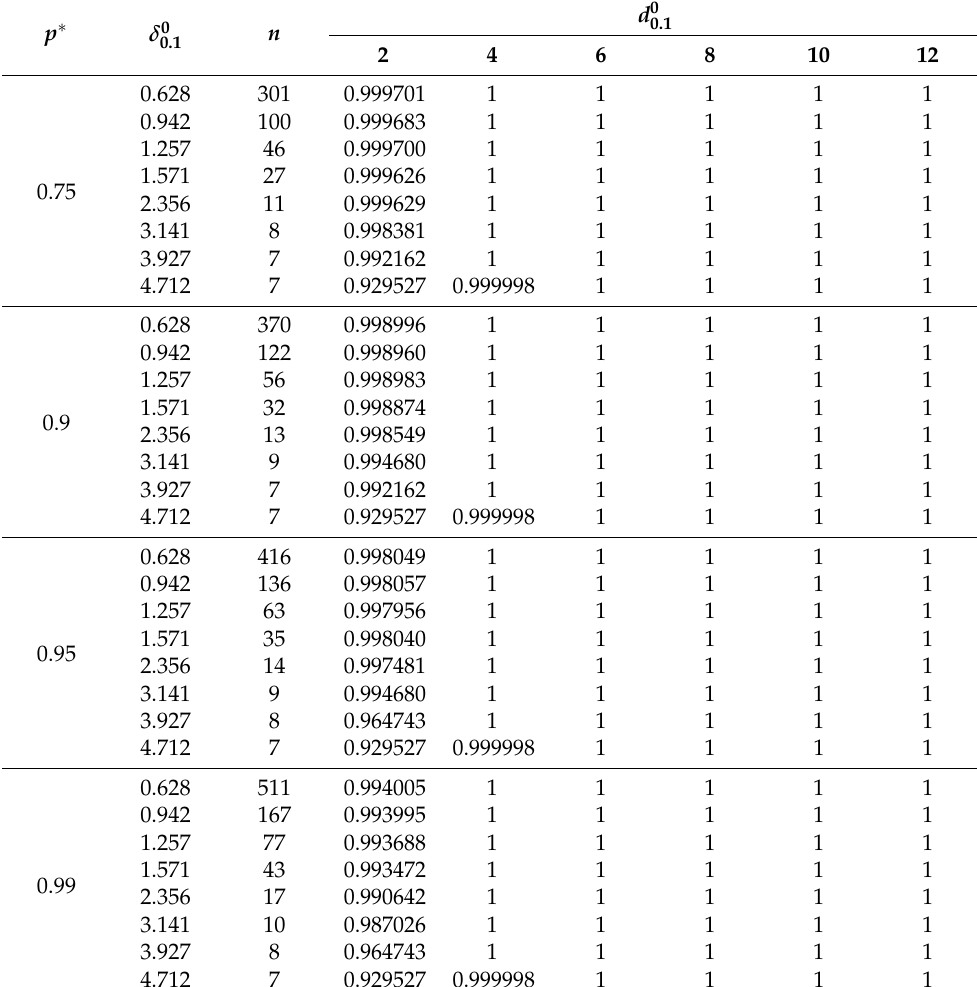
Table 3. OC values of sampling plans of c = 6, for a given p ∗ with η = 2.793 and α = 1.011 for the